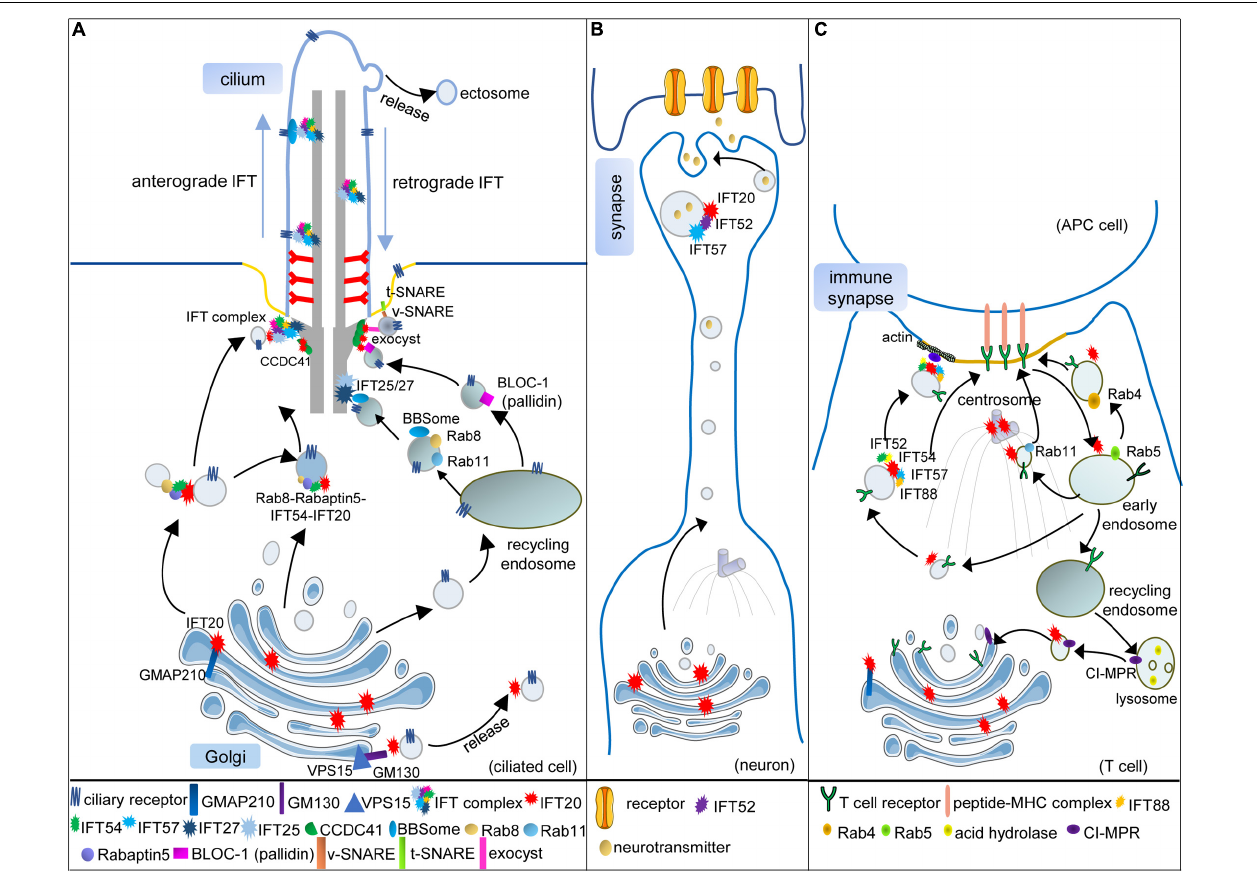
FIGURE 1 | Vesicular trafficking function of IFT subunits in ciliated and non-ciliated cells. (A) In the ciliated cell, IFT20 localizes at both the cilium and the Golgi and transports the ciliary receptors from the Golgi to the cilium. Golgi resident protein GMAP210 recruits IFT20 at the Golgi. Another Golgi resident protein GM130, along with VPS15, regulates the release of IFT20-associated vesicles from the Golgi. IFT54 interacts with IFT20 and Rabaptin5, an effector of Rab8, to mediate the interaction of Rab8-Rabaptin5-containing and IFT20-containing vesicles when these vesicles are directed to the base of the cilium. At the basal body, these vesicles can be assembled with the other IFT subunits, and anterograde IFT trains transport ciliary receptors into the cilium. Some ciliary receptors could also be transported by recycling endosomes with the help of Rab8, Rab11, and BBSome. When the vesicles carrying Rab8, Rab11, and the BBSome reach the basal body, IFT25/27 interact with the BBSome to facilitate ciliary receptors incorporating into IFT trains. The BLOC-1 complex is also associated with the ciliary receptors in recycling endosome-derived vesicles. Moreover, IFT20 is partially responsible for the basal body localization of pallidin, one subunit of the BLOC-1 complex. Two components of the exocyst complex (Exo70 and Sec8) also interact with IFT20 at the basal body, which might facilitate the interaction of v-SNARE and t-SNARE. One component of DAPs, CCDC41, can recruit IFT20 to the basal body where several IFT subunits associated with vesicular trafficking are assembled into the whole IFT